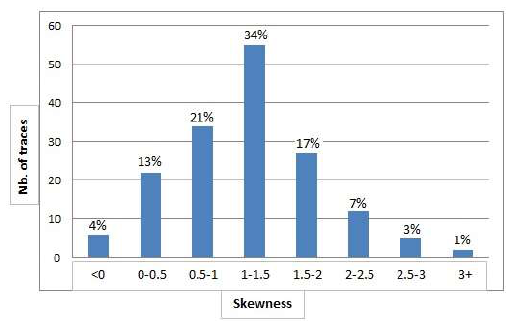
Figure 6. Distribution of skewness of speed values per trace in the test area.